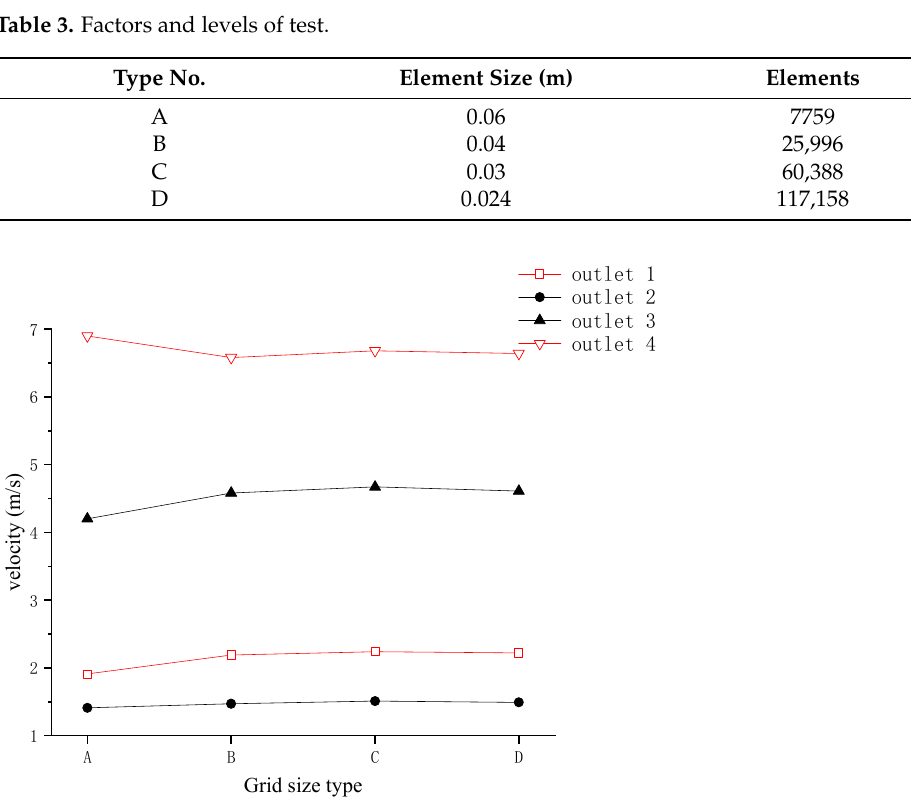
Figure 7. Exit velocity variation plots under different grid-size types.